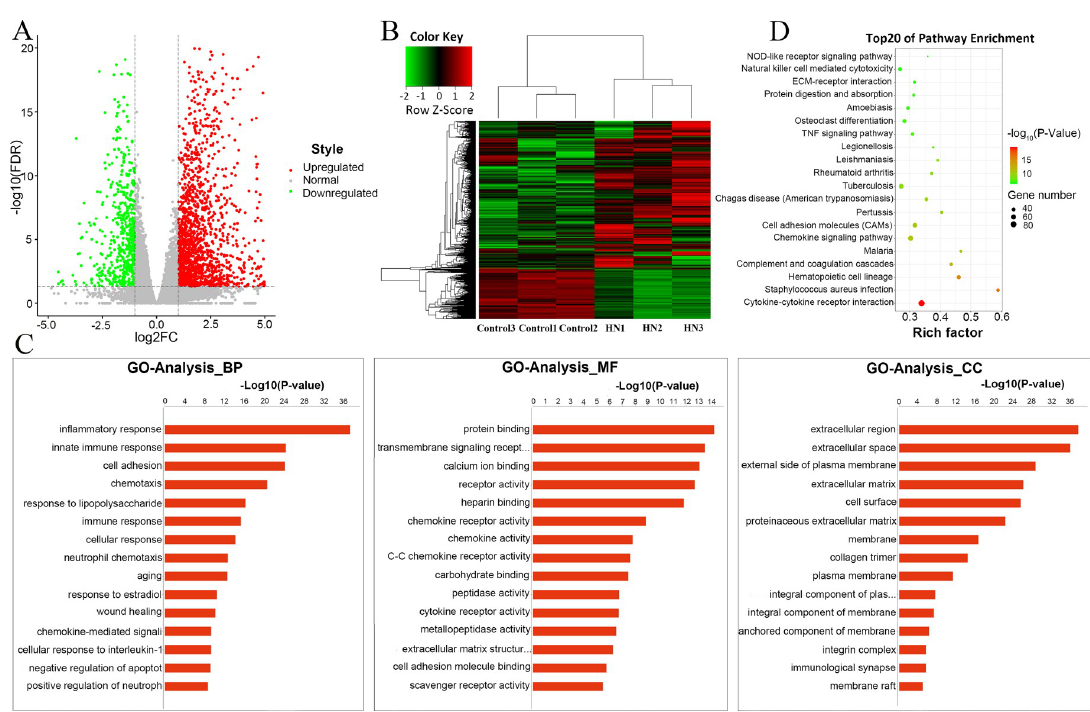
Fig 4. The identification and further analysis of DEGs. (A) Volcano plot for the comparison between HN rats and the rats of the control group. Red points indicate upregulated mRNAs [log2 (fold change) > 1, FDR < 0.05], while green nodes indicate downregulated mRNAs [log2 (fold change) > -1, FDR < 0.05]. Grey dots refer to normally expressed mRNAs. (B) Heatmap analysis was used to determine the differential expression between the HN group and the control group. Each row indicates a single mRNA, and each column indicates a tissue sample. (C) Gene Ontology analysis of DEGs, including MF, CC and BP classification. The horizontal axis is the enrichment value of functional degree, and the vertical axis is the entry name corresponding to GO in the Gene Ontology database. (D) Kyoto Encyclopedia of Genes and Genomes pathway analysis of DEGs. The size of the bubbles indicates the number of genes involved in pathways; bubble colour indicates the P-value. DEGs, differentially expressed genes; HN, hyperuricaemic nephropathy; mRNA, message RNA; FDR, false discovery rate; GO, Gene Ontology; MF, molecular function; CC, cellular component; BP, biological process.